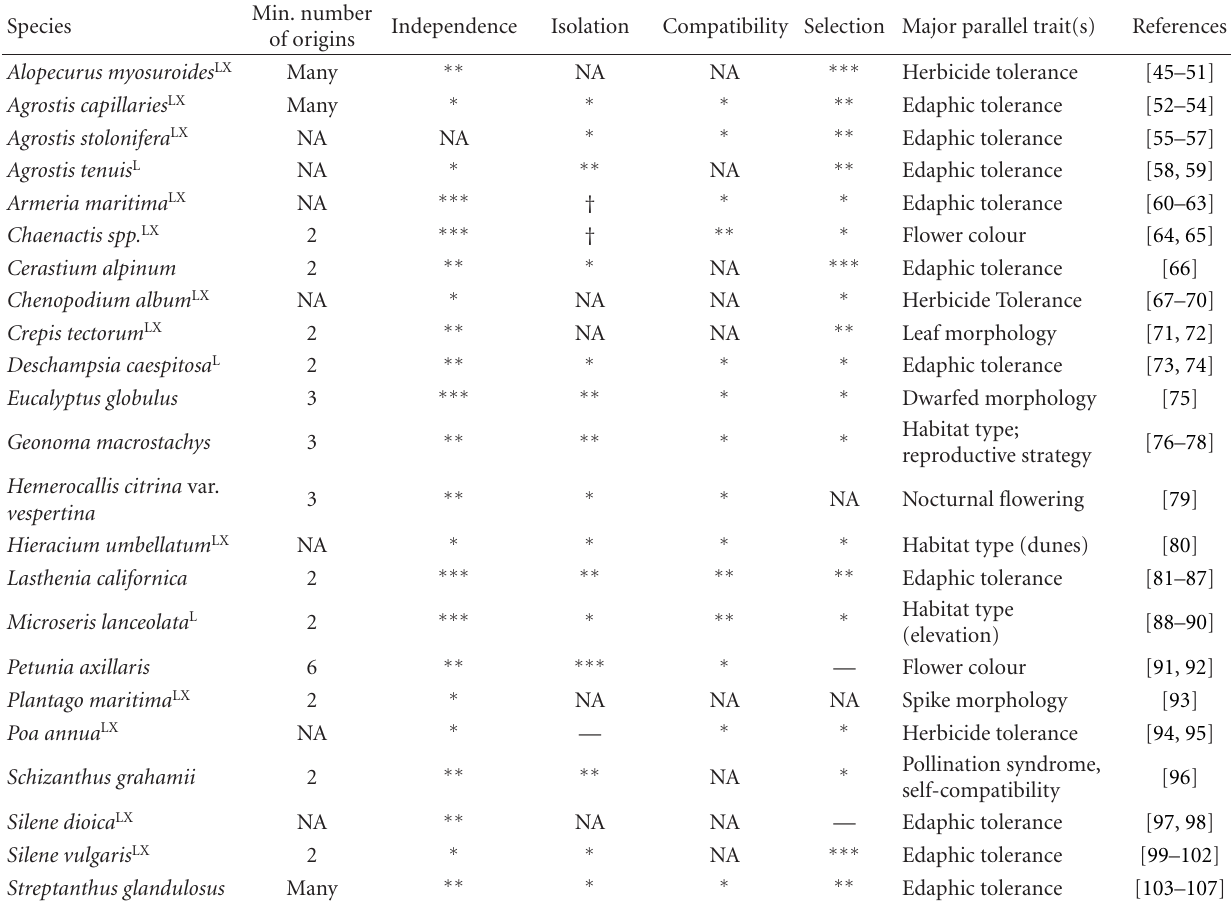
Table 1: Candidate examples of parallel ecological speciation in plants showing the strength of evidence for each case. The details of each example can be found in Appendix A. The strength of evidence for each case was coded as follows: ∗∗∗ : strong direct evidence, ∗∗ : weak direct evidence, ∗ : indirect evidence, —: no evidence, † : evidence against, and NA: no data.